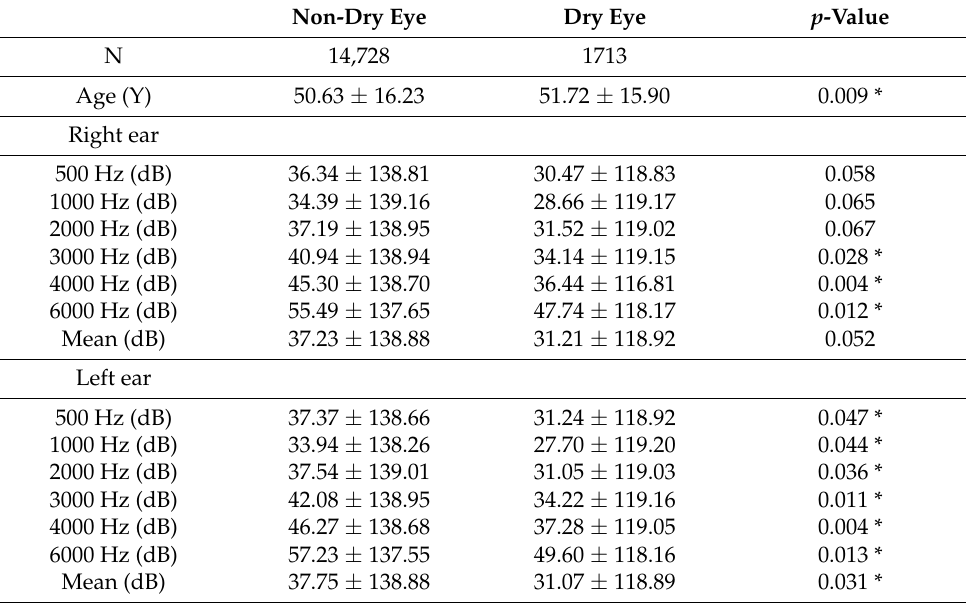
Table 4. Auditory thresholds according to dry